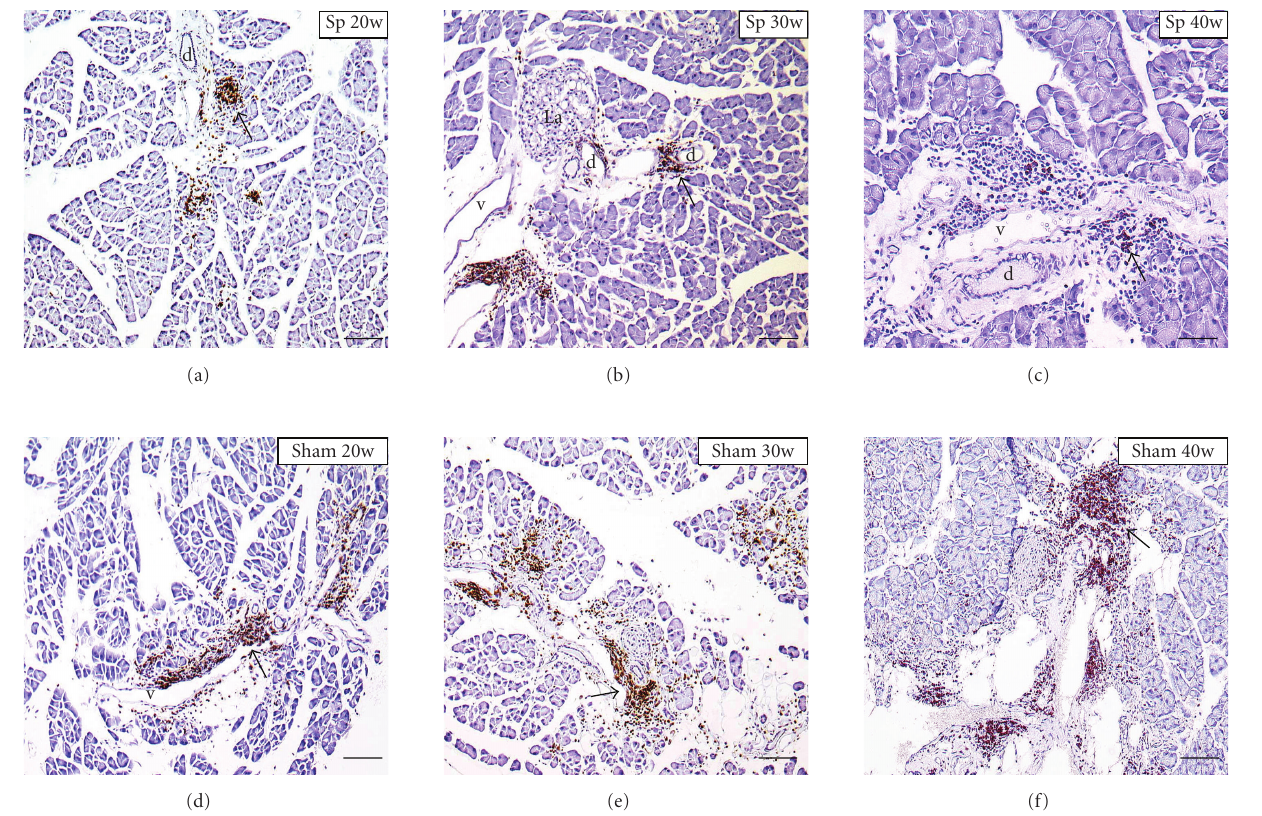
Figure 3: Immunohistopathological analysis of pancreas in splenectomized (Sp) and sham aly/aly mice by CD4. Arrows, indicating CD4- positive cells. a, artery; d, pancreatic duct; La, islet of Langerhans; v, vein. Scale bars: 100 μ m (c); 200 μ m ((a), (b), (d), (e), and (f)).